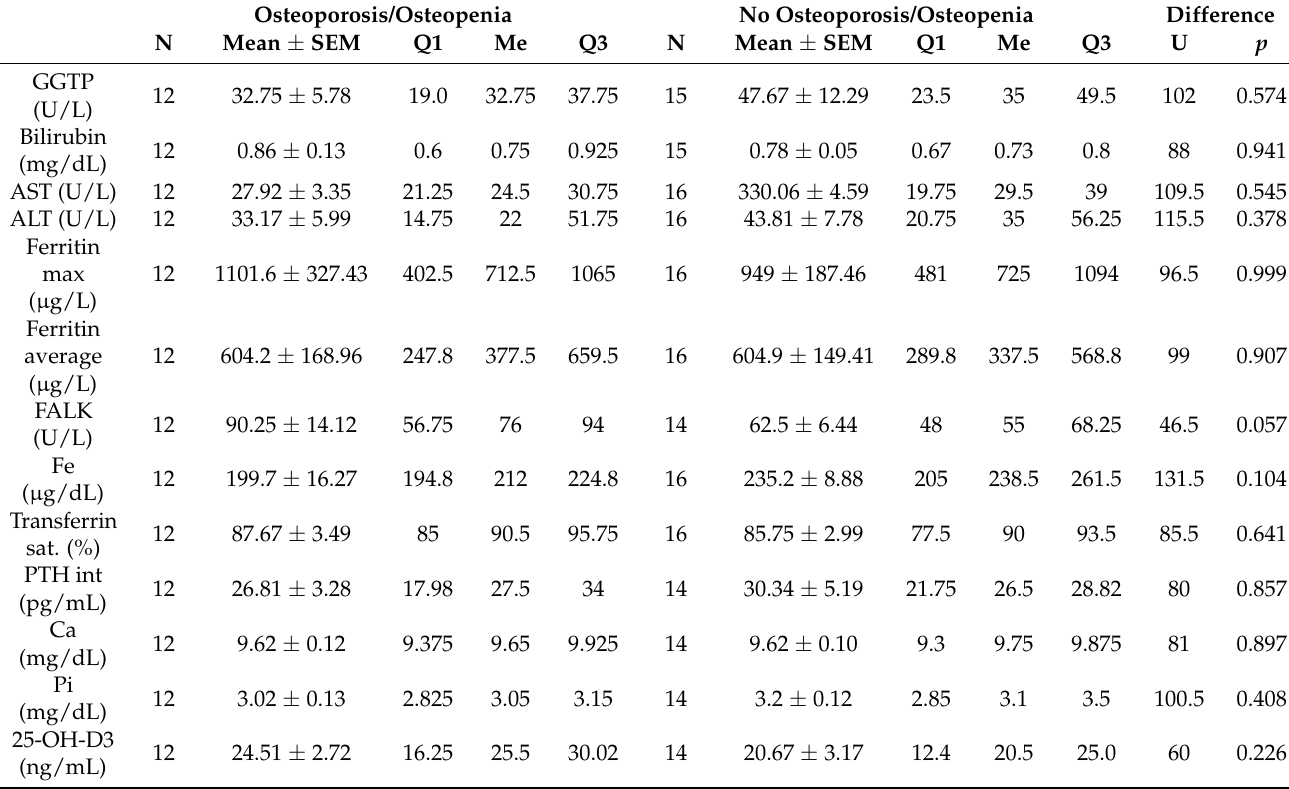
Table 3. Selected liver function tests, iron parameters and calcium-phosphate metabolism in HH patients in the groups with osteoporosis/osteopenia and without osteoporosis/osteopenia. Osteoporosis/Osteopenia No